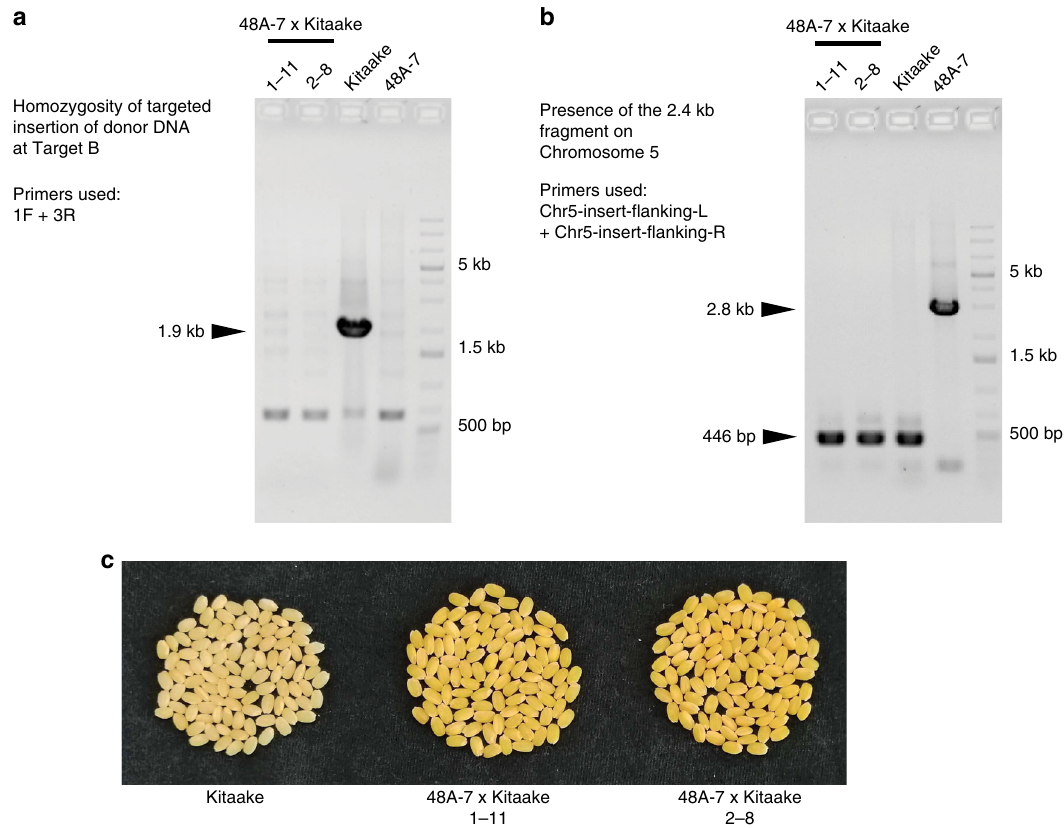
Fig. 5 Removal of the 2.4 kb plasmid fragment from 48A-7 by backcross. a Checking the homozygosity of the carotenoid cassette inserted at Target B in the F2 individuals 1 – 11 and 2 – 8 from the backcross between 48A-7 and Kitaake. PCR primers 1F and 3R anneal to genomic positions fl anking Target B, as shown in Fig. 2a, amplifying a 1.9 kb genomic DNA fragment unless the carotenoid cassette at Target B is homozygous. Kitaake and 48A-7 were used